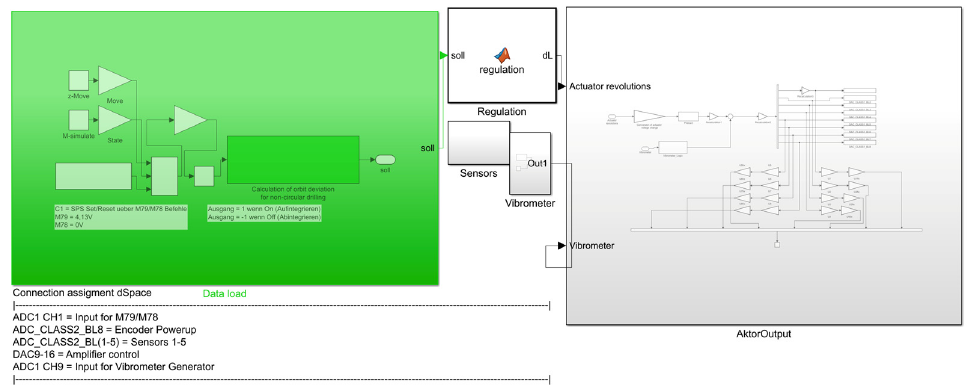
Figure 6. Basic communication blocks Simulink to dSpace.